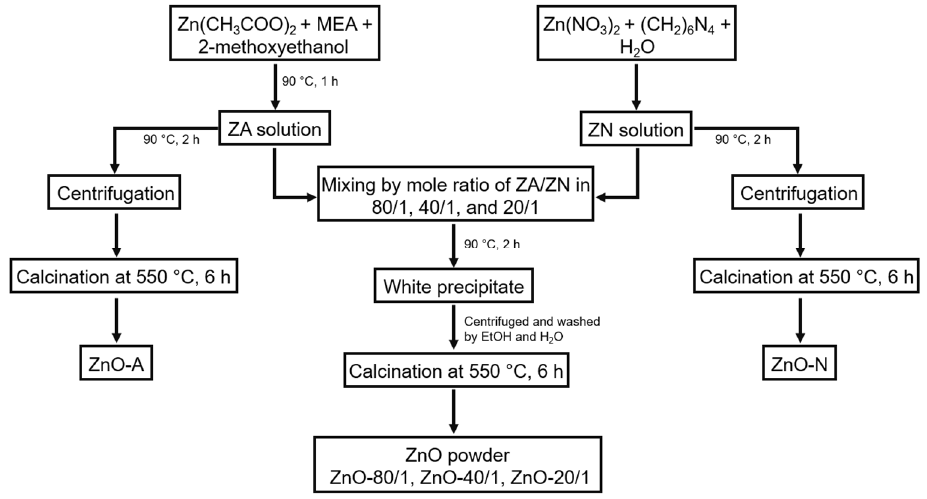
Figure 1. Schematic flow chart of ZnO powder preparation yielding ZnO ‐ 80/1, ZnO ‐ 40/1, ZnO ‐ 20/1, ZnO ‐ A, and ZnO ‐ N.